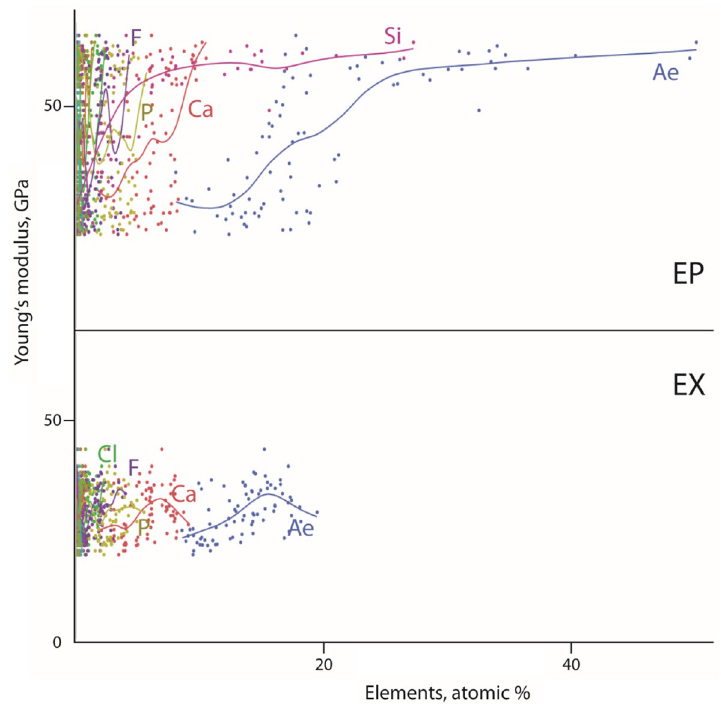
Figure 8. Relationship between the Young’s modulus, given in GPa, and the proportions, given in atomic %, of each individual element and Ae for the epicuticle ( above ) and the exocuticle ( below ). Ae all elements, EP epicuticle, EX